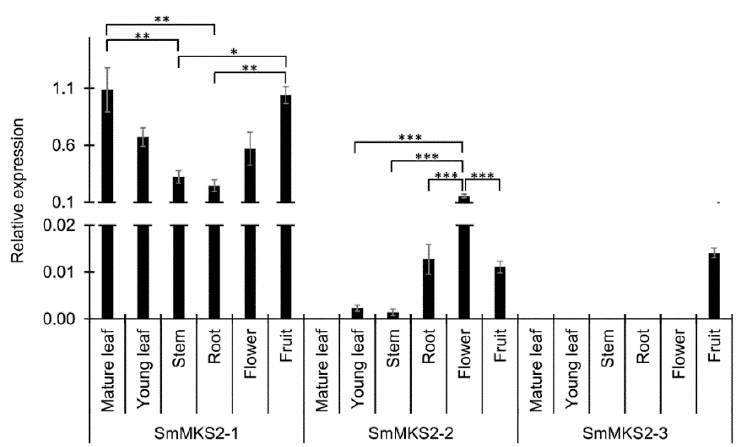
Figure 3. Spatial expression patterns of three SmMKS2 genes in eggplant determined by quantitative real-time polymerase chain reaction (qRT-PCR) analysis. Transcript levels were normalized with respect to the adenine phosphoribosyl transferase gene ( APRT , Genbank accession: JX448345.1). Values are mean ± standard error (SE) from three replicates. Significant differences were assessed by one-way analysis of variance (ANOVA) followed by Tukey’s test: * p < 0.01, ** p < 0.005, *** p < 0.001.